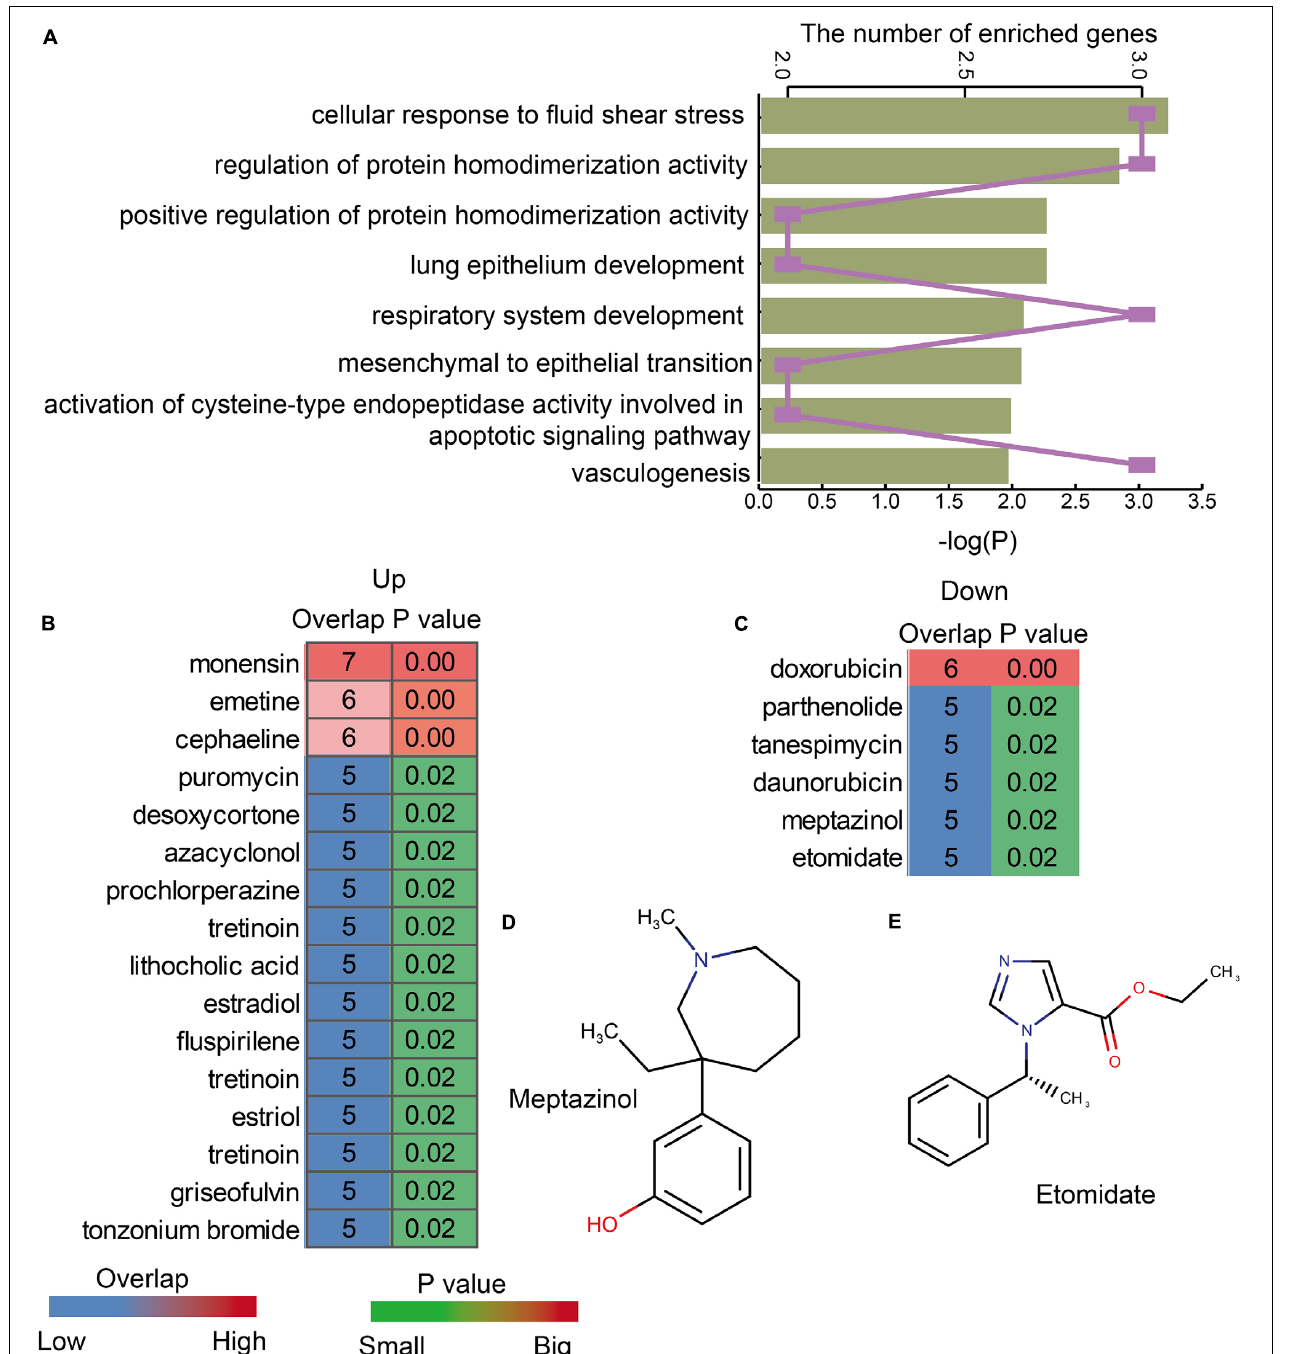
FIGURE 5 | LUAD- and LUSC-specific lnc-eQTMs were associated with some essential functions and drugs. (A) Bar chart showing the P -values of enriched GO terms and line chart showing the number of enriched genes. (B) Heatmap showing the upregulated drugs associated with lnc-eQTMs. (C) Heatmap showing the downregulated drugs associated with lnc-eQTMs. (D) The chemical constitution of Meptazinol. (E) The chemical constitution of